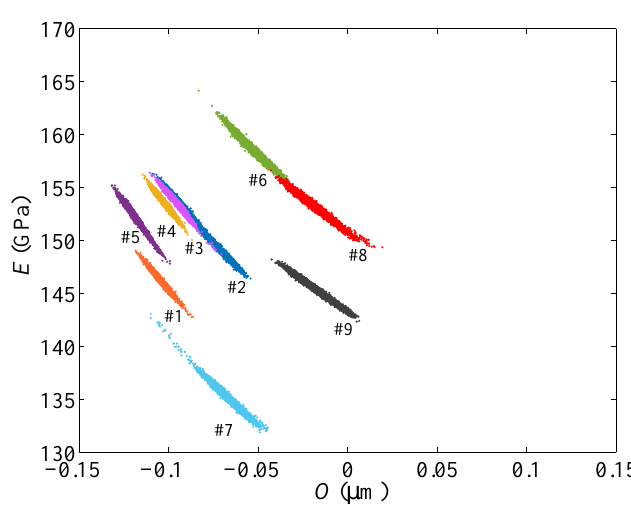
Figure 6. Final posterior distributions of the TMCMC samples in the O – E domain, as obtained for nine of the tested devices.